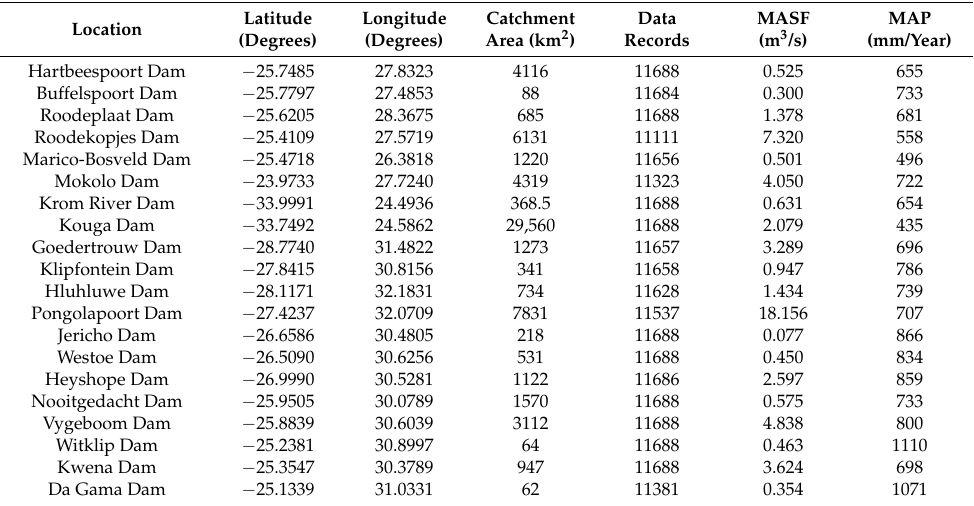
Table 2. Rainfall and streamflow characteristics of some of the stations considered in the study.